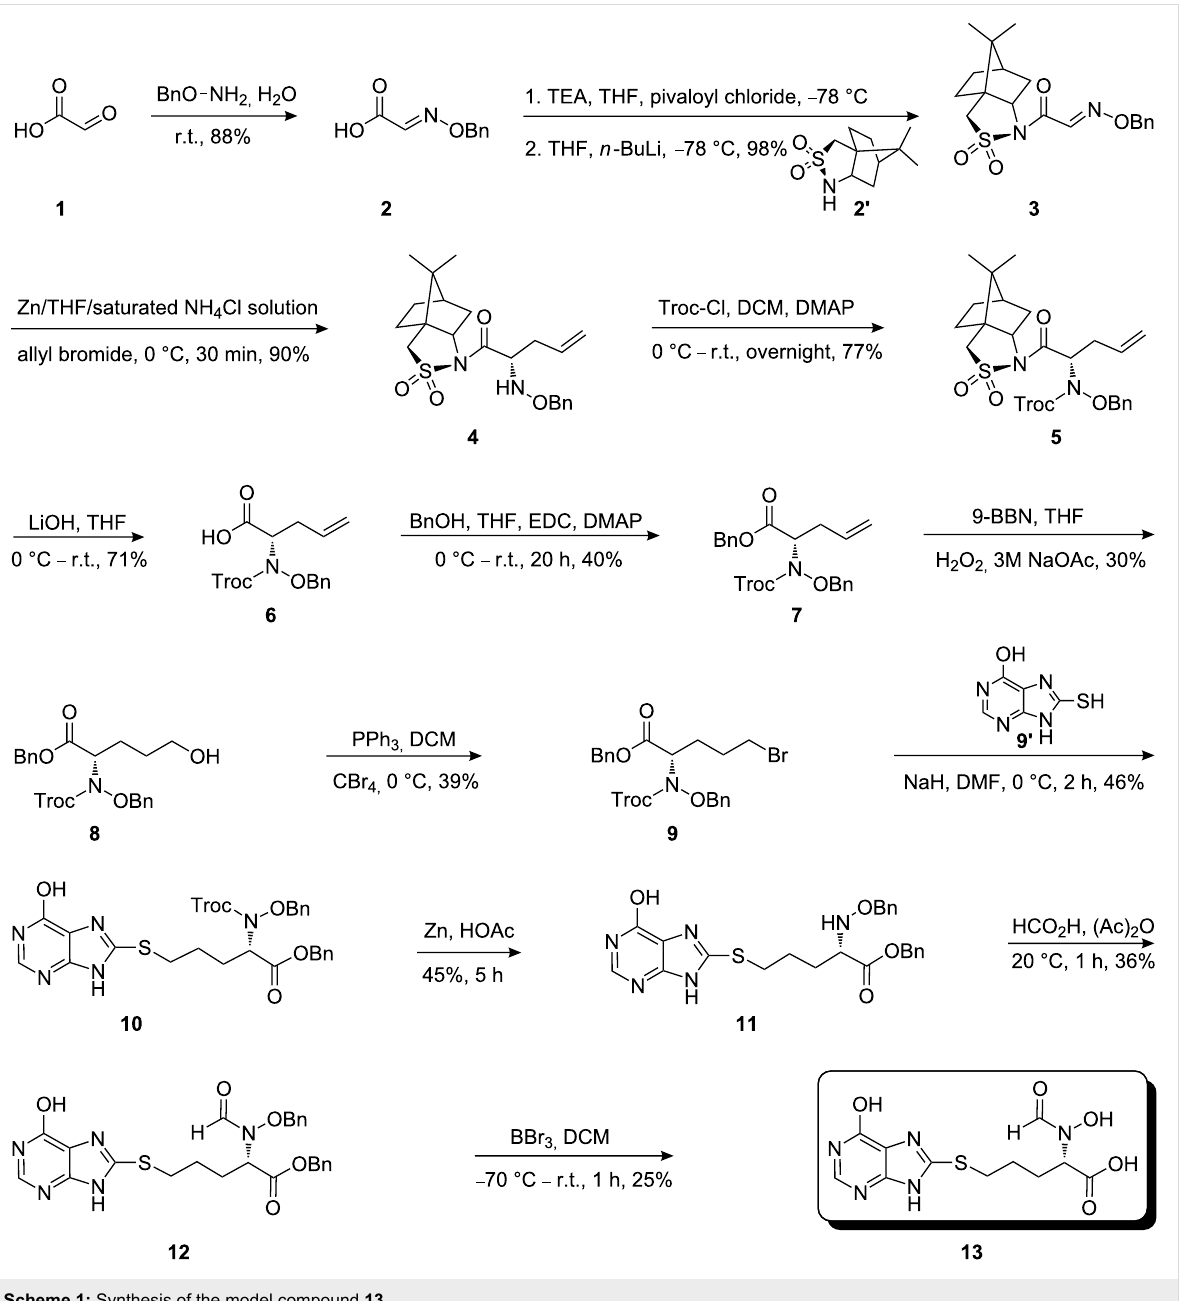
Scheme 1: Synthesis of the model compound 13